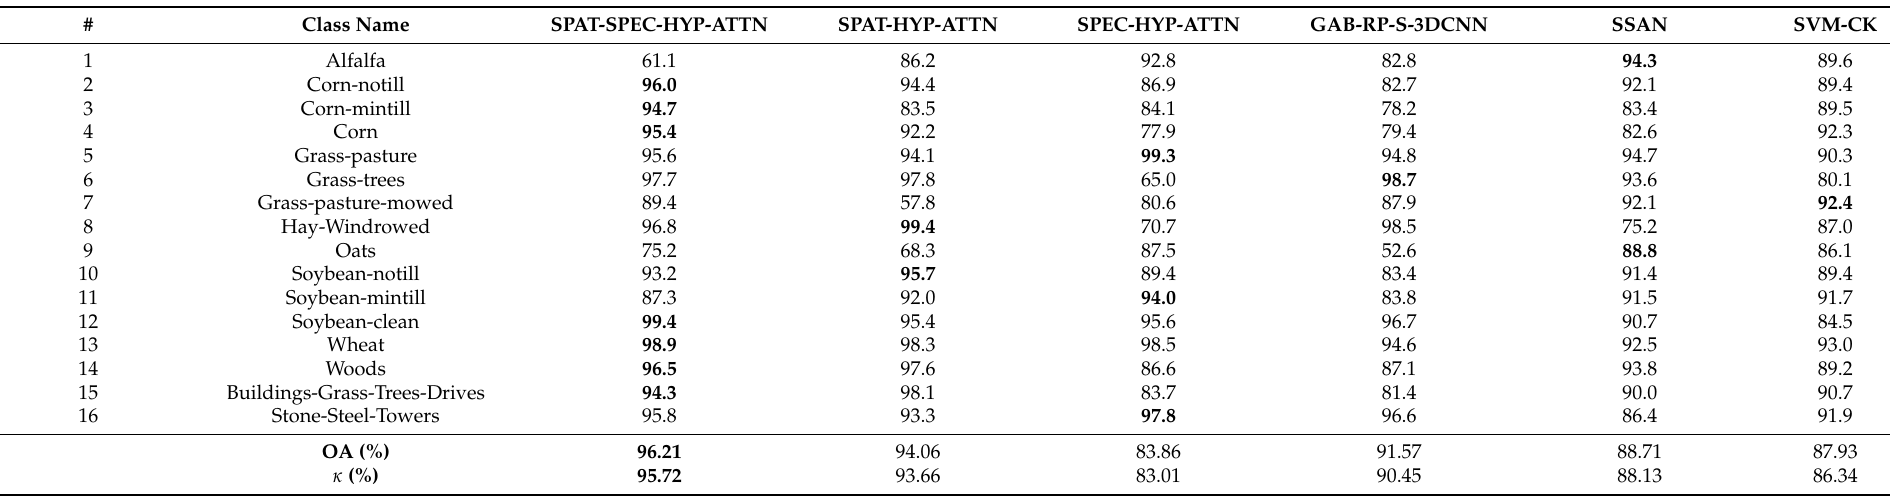
Table 6. Class-specific accuracies of Indian Pines dataset for 5% of training data for the proposed classification methodologies and models used for